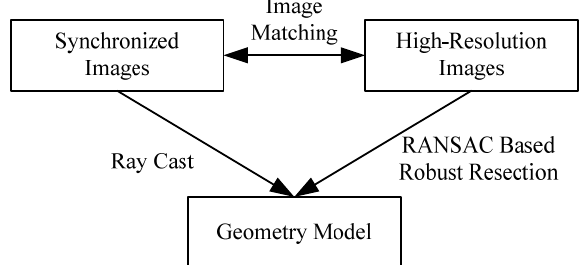
Figure 5. The Sketch Map of Automatic Registration for High- Resolution